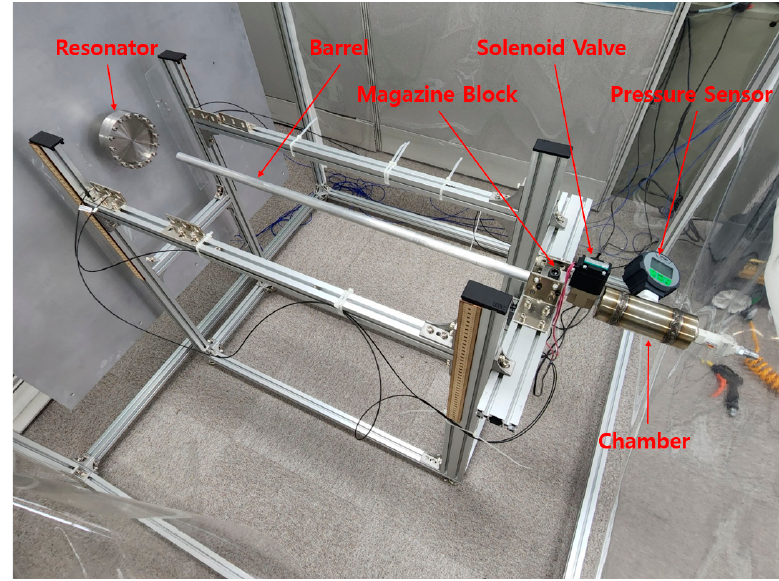
Figure 16. Developed launch device. Table 2. Design parameters of launch device.